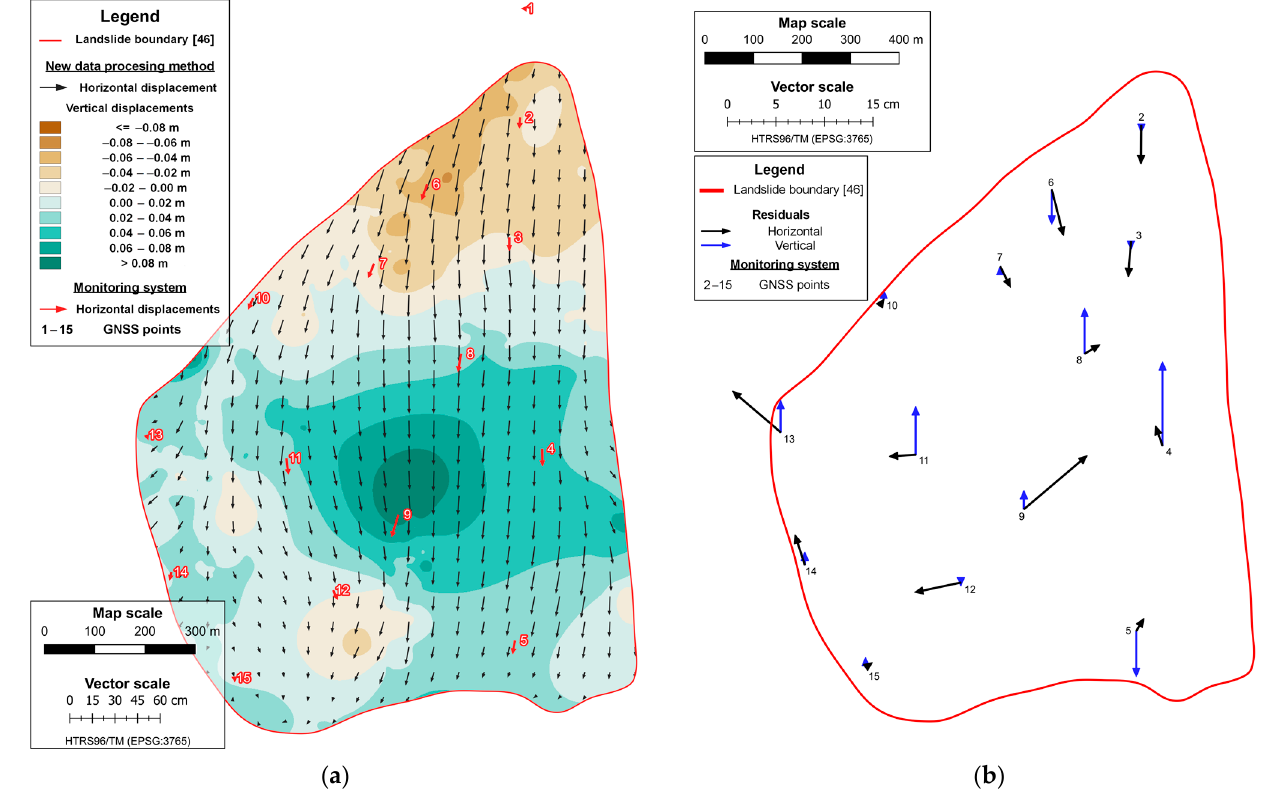
Figure 15. Displacement map of the Kostanjek landslide (24 April 2017–2 May 2019) ( a ) and residuals in 14 GNSS monitoring system points ( b ). Table 8. Statistics of residuals between the determined and referent displacement vectors values and RMSE of determining displacements with the proposed data processing